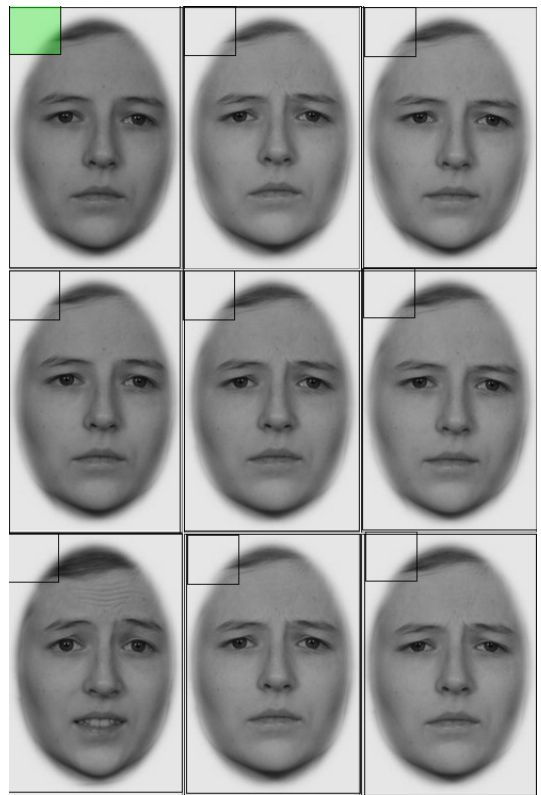
Figure A1. Pseudo-example item for the Cube Comparisons Task. In this example, the two cubes must be different, as the A and E occupy the same position (below the C, and to the left of the D), and any letter can only appear once on each cube.